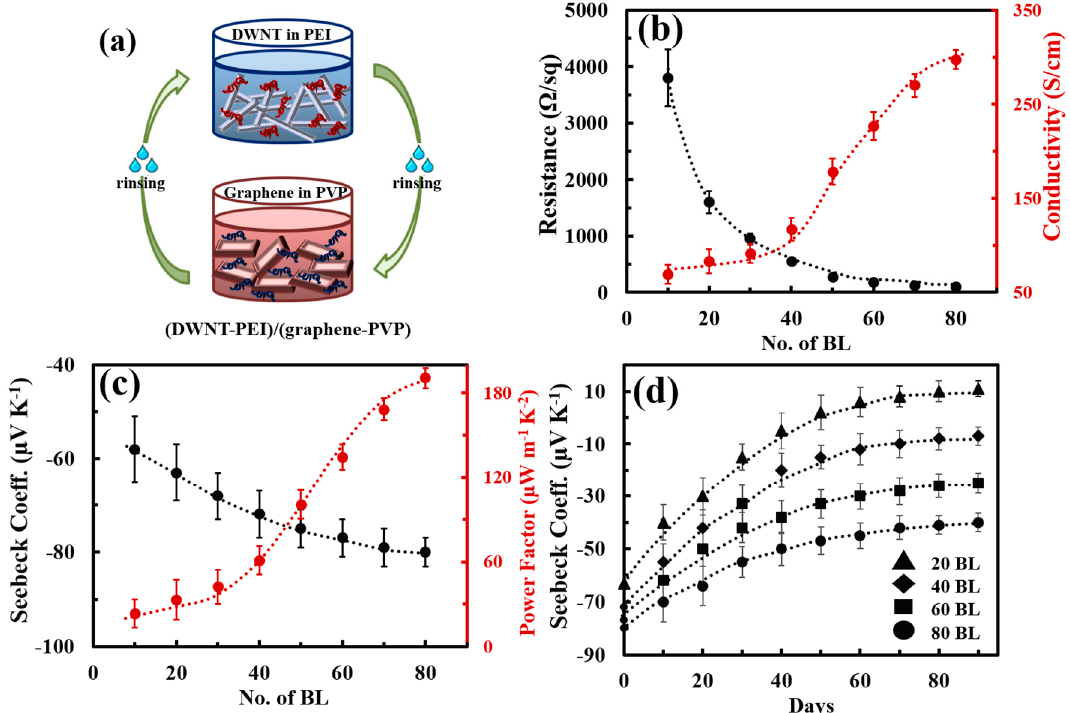
Figure 10. ( a ) The schematic of the layer ‐ by ‐ layer deposition process and molecular structures of the materials used. ( b ) Sheet resistance and electrical conductivity and ( c ) Seebeck coefficient and power factor, and ( d ) air ‐ stability of Seebeck coefficient under ambient conditions. Reprinted with permission from [81]. Copyright 2016